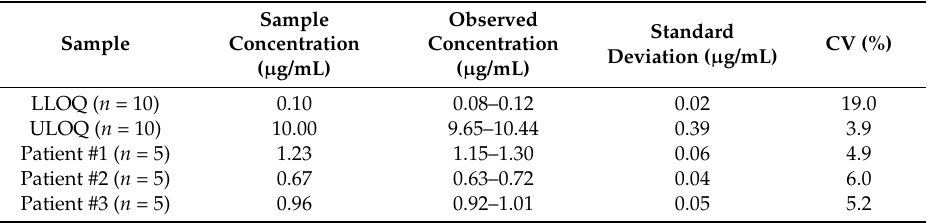
Table 2. Method validation.